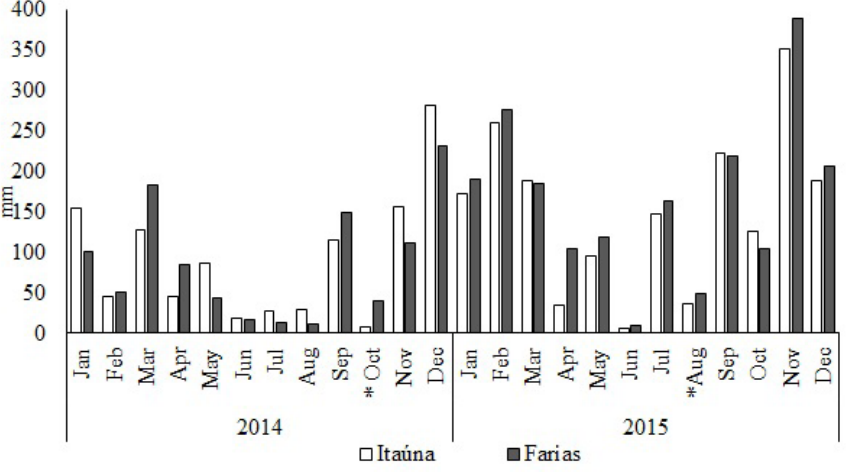
Figure 2. Values of rainfall (mm) measured in the municipalities of Itatinga (Itaúna stream) and Avaré (Farias stream) in the two years in which the study was carried out, being indicated (*) the two months of collection in the dry season (October 2014 and August